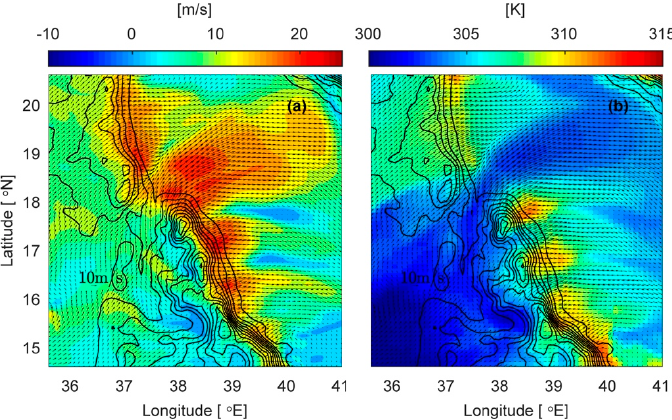
Figure 8. Plan views of 10 m wind speed ( a ) and ground-level potential temperature ( b ) at 05 UTC on 12 July 2008. Velocity arrows at 10 m are shown in both frames. 12 July 2008. Velocity arrows at 10 m are shown in both